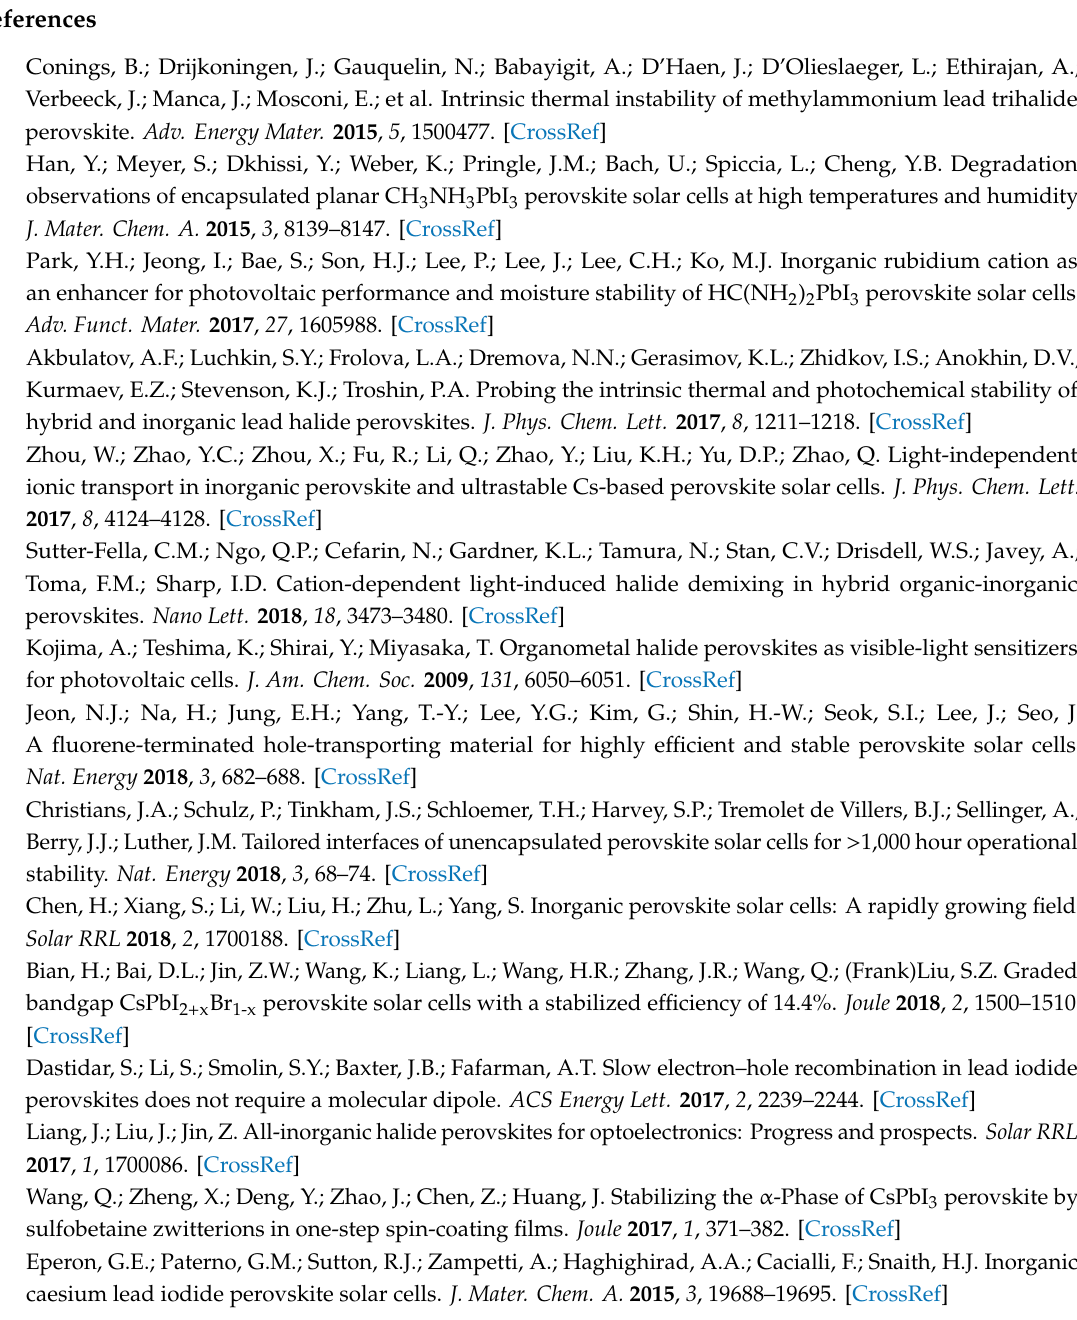
Figure S1: ( a ) XRD pattern and ( b ) EDS spectra of the m-TiO 2 / PED film; Figure S2: ( α h ν ) 2 vs. h ν plots of the m-TiO 2 / CsPbIBr 2 with and without PED